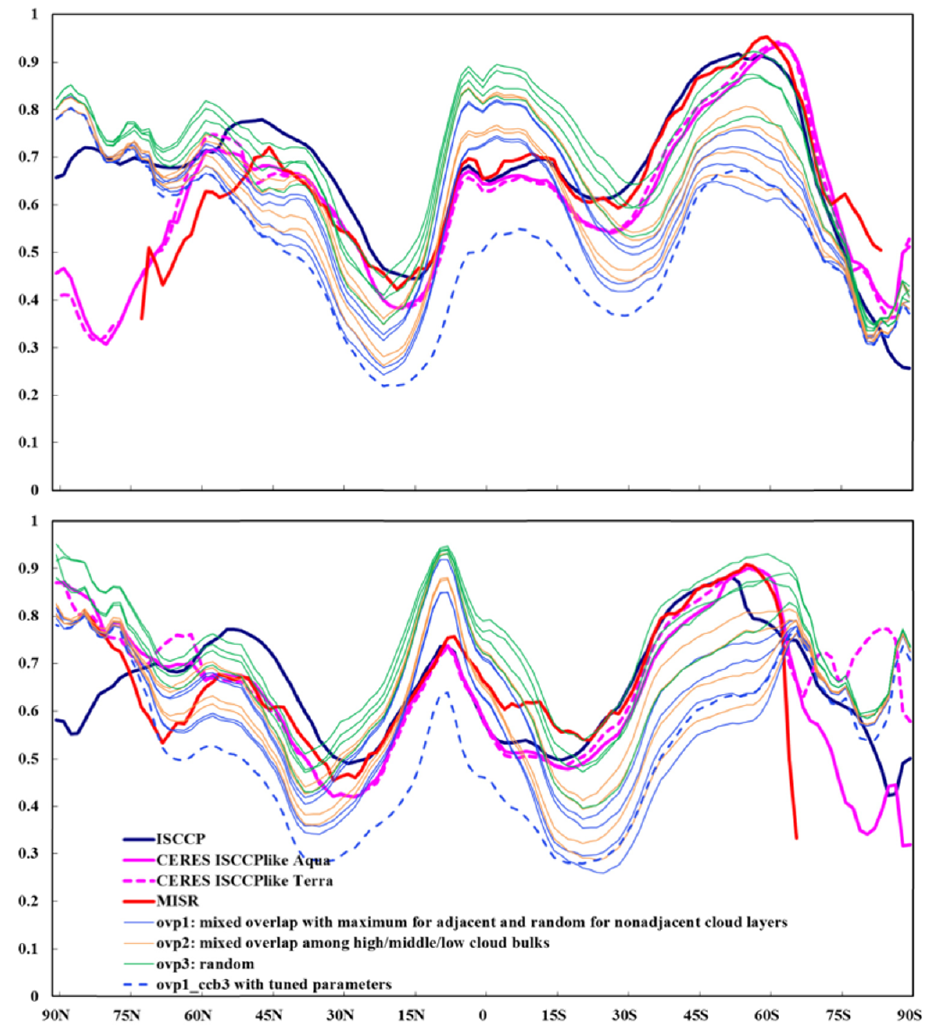
Fig. 6. Zonal mean total cloud cover fractions for January (top) and July (bottom) 2004 among three vertical overlap schemes built in CAR, as compared with four satellite products. For each overlap scheme, four cloud cover prediction schemes are shown using the same